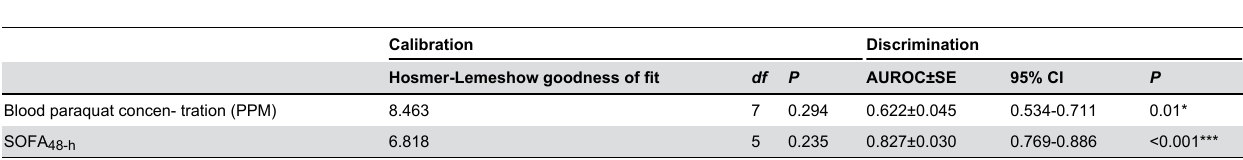
Table 4. Comparison of calibration and discrimination power of SOFA scoring methods for predicting ARDS (n=187).